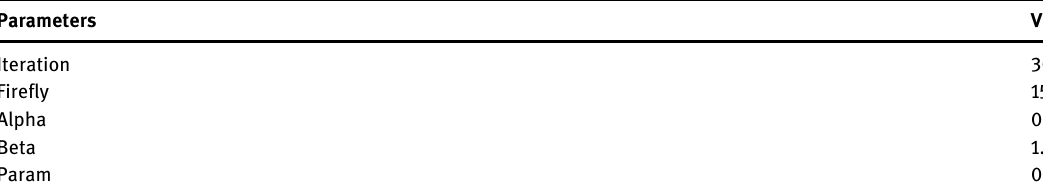
Table 1: Fire fl y search parameters